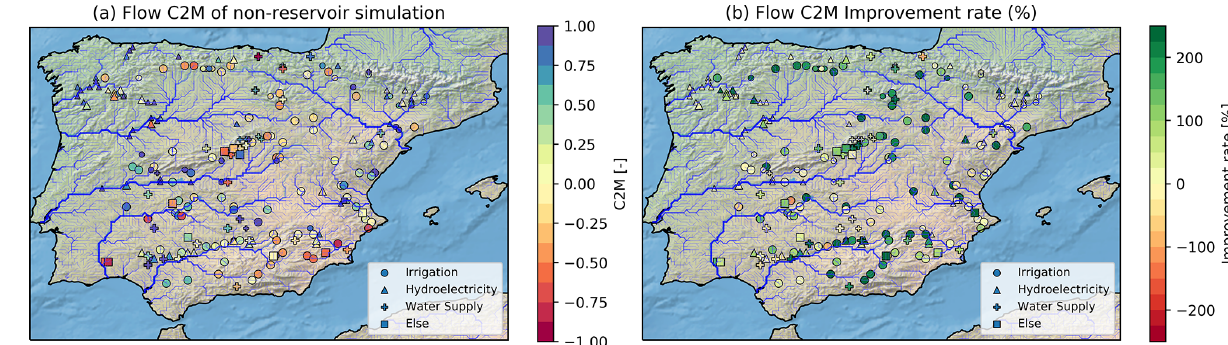
Figure 3. Results of the DROP model contribution (default configuration) in river flow modeling at reservoir outlets: (a) C 2M performance metrics of non-reservoir simulation (reference simulation where Q out = Q in ) and (b) C 2M improvement rates by integrating the reservoir model. Symbols represent the different reservoir management purposes. They come in two different sizes: larger if c ≥ 0 . 5 and smaller if c < 0 . 5.